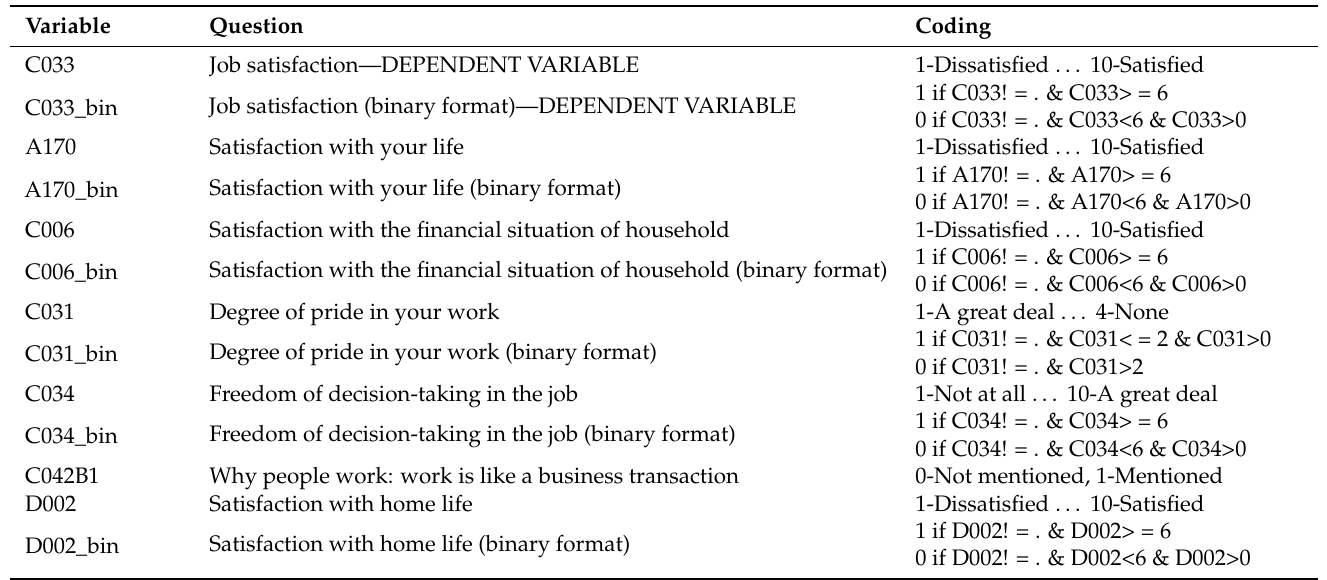
Table A1. Important World Values Survey items and corresponding variables, namely, the dependent one (two forms) and six independently selected at the end of the first two mining rounds (Figure A1, Appendix A).